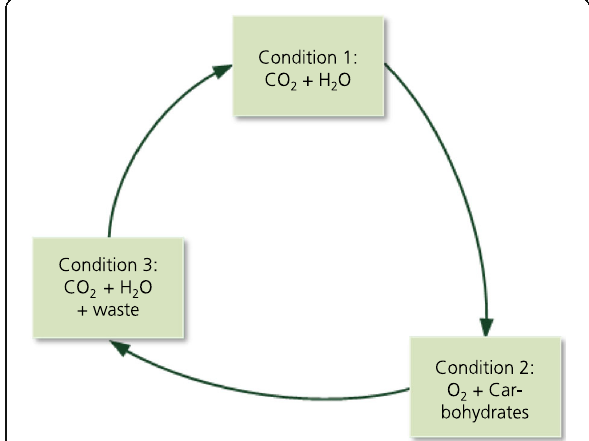
Fig. 1 An example for a closed loop. Beginning with CO 2 and H 2 O, these can be transformed e.g. via plant growth to O 2 and Carbohydrates (i.e. edible bio mass). Consumption, e.g. by the human crew, transforms these via metabolism to CO 2 and H 2 O again, yet also waste (either from the human metabolism or e.g. in the form of non-edible biomass). This waste has to be transformed into its constituents again, resulting in the initial condition. This is a simplified representation. Actual compositions of materials are more complex (e.g. including